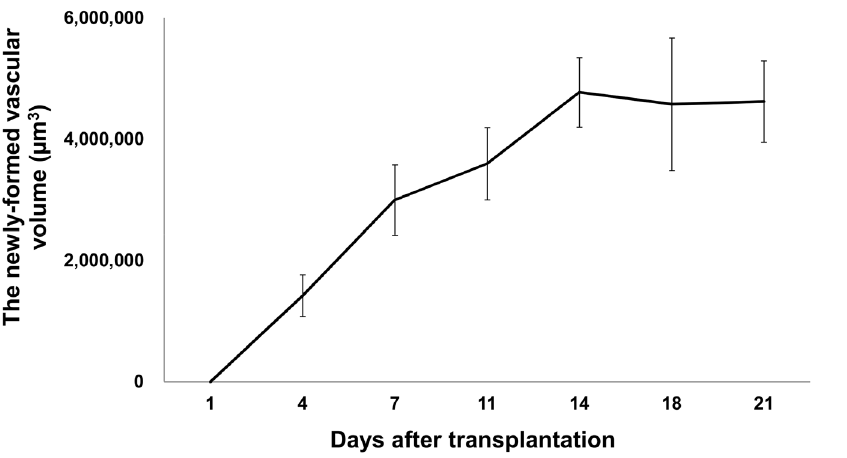
Figure 2. The time-dependent changes of newly-formed vascular volume for the transplanted pancreatic islets. Newly-formed vascular volume surrounding the islets at 4, 7, 11, 14, 18, and 21 days after transplantation was measured by using a Volocity system. All values are